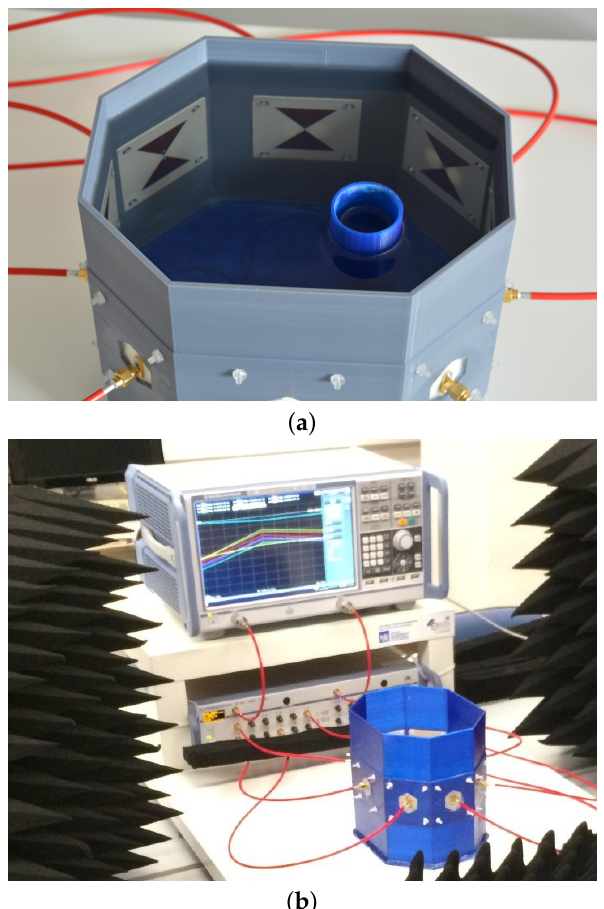
Figure 2. Experimental Assessment. ( V = 8, f 0 = 900 MHz, (cid:101) ε B = 41.8 ε 0 − j 0.97 S = 48.63 ε − j 1.28 )—( a ) Detail of the fabricated head/stroke phantoms and ( b ) experimental (cid:101) ε 0 H 2 π f 0 acquisition